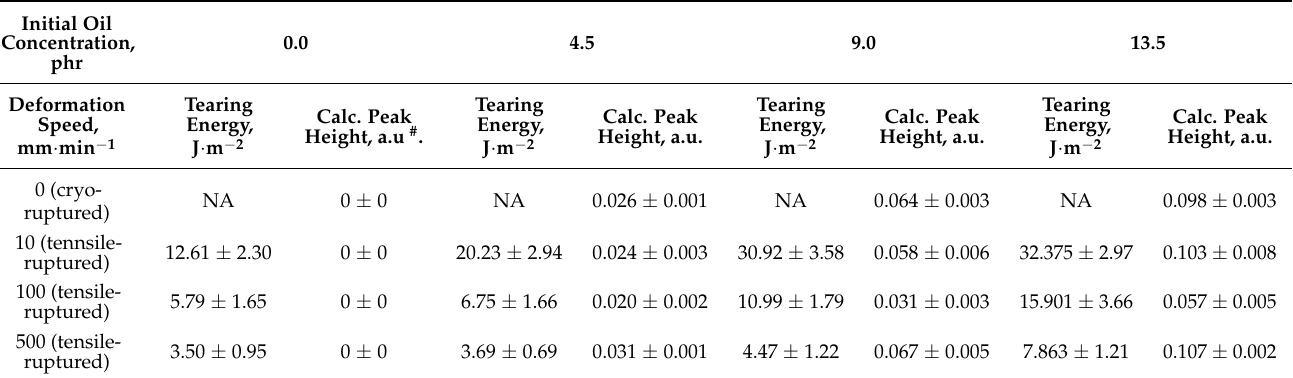
Table 3. Tearing energy and the corresponding absorption peak height at 2915 cm − 1 (representing the redistributed oil concentration after rupture).